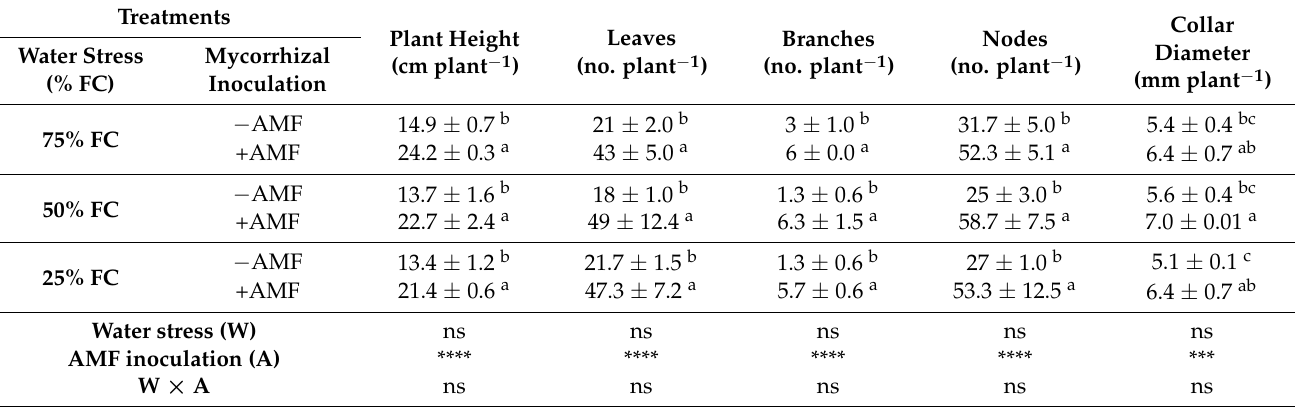
Table 1. Morphological traits of C. spinosa seedlings grown without ( − AMF) or with (+AMF) mycor- rhizal fungi inoculum under three water stress levels (%